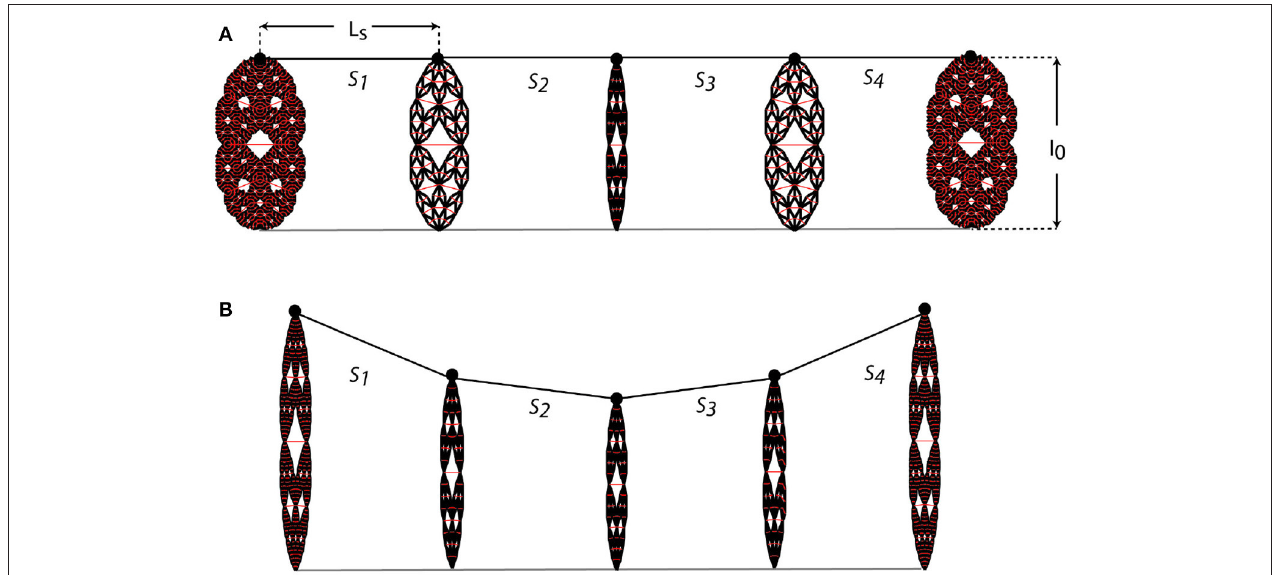
FIGURE 16 | Deployable support structure. (A) Initial configuration, (B) Deployed configuration.